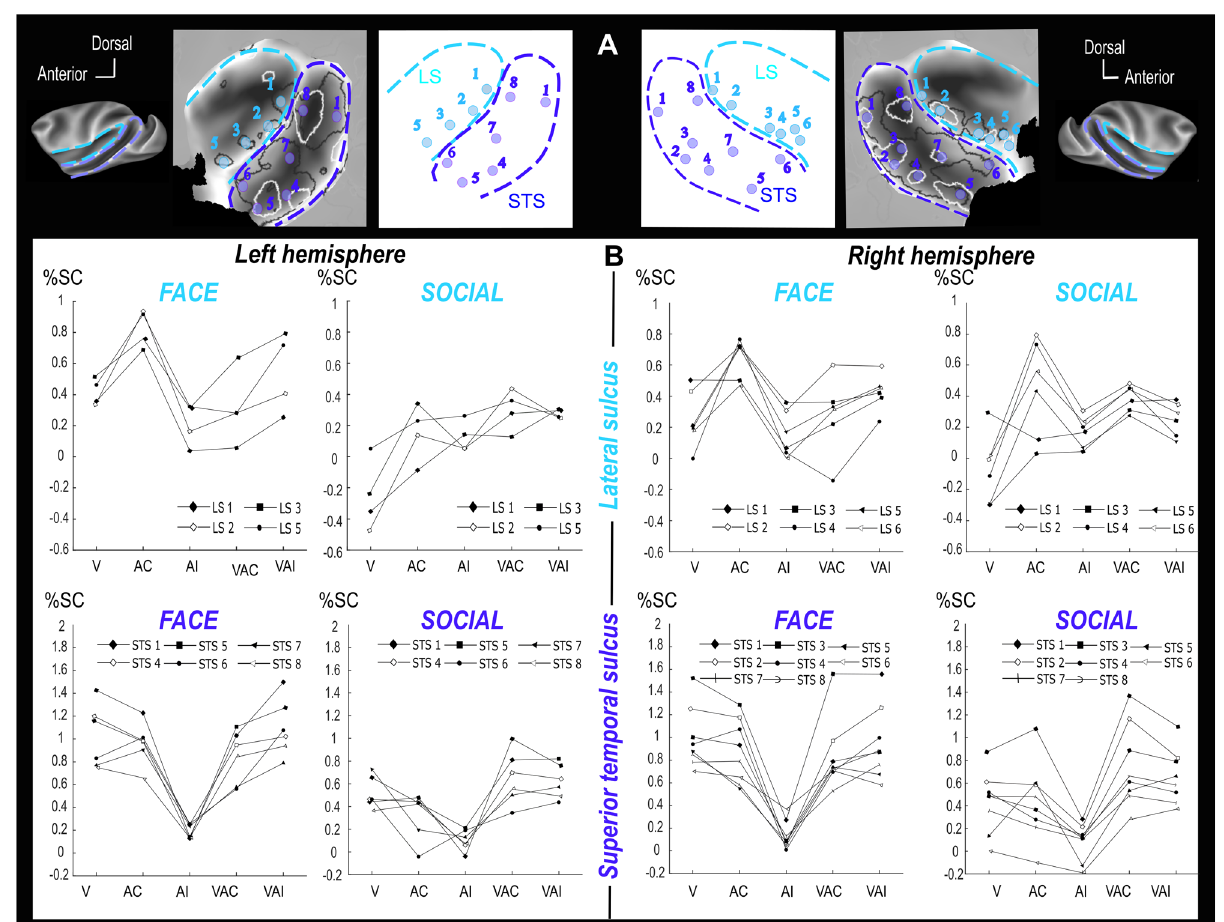
Fig.7|Percentageofsignalchange(%SC)forselectedleftandrighthemisphere ROIs in the lateral sulcus (light blue) and in the superior temporal sulci (dark blue). A ROIs are 1.5mm spheres located at local peak activations. Left and right hemisphere numbering associate mirror ROIs. ROI location in the each of the left and right STS and LS is described in the bottom fl at maps. B %SC (median) are